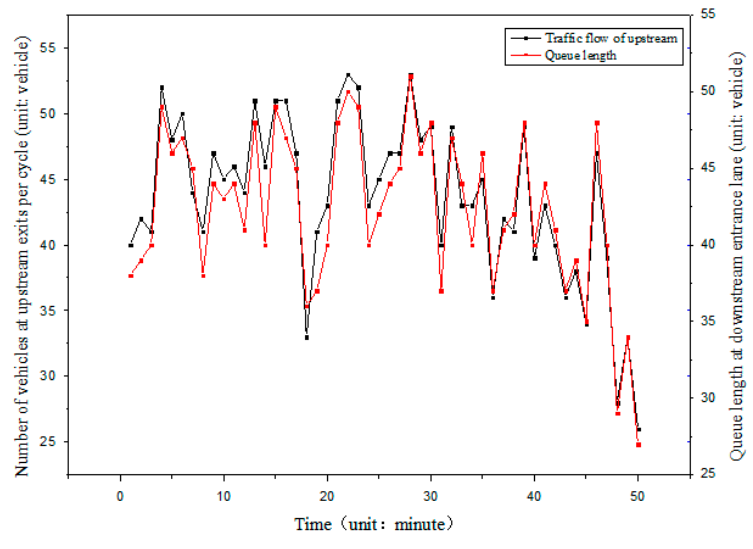
Figure 4. Relationship between traffic volume and queue length.